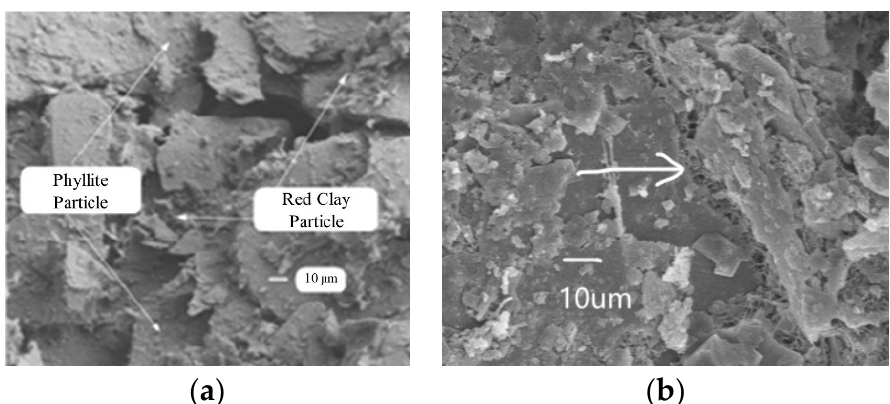
Figure 14. Network cementation of cement products between soil particles ( a ) η = 0 and ( b ) η = 3%.